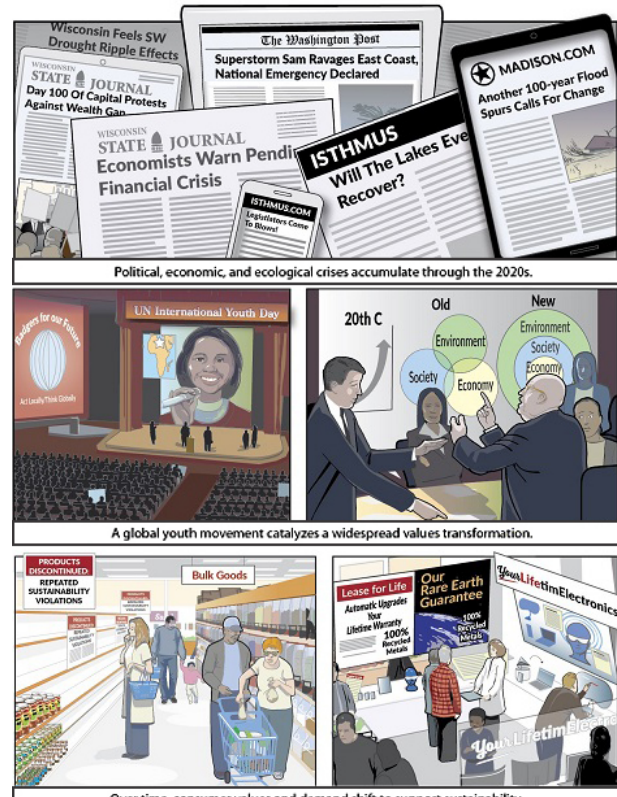
Fig. 7 Timeline of major events in the “Connected communities”